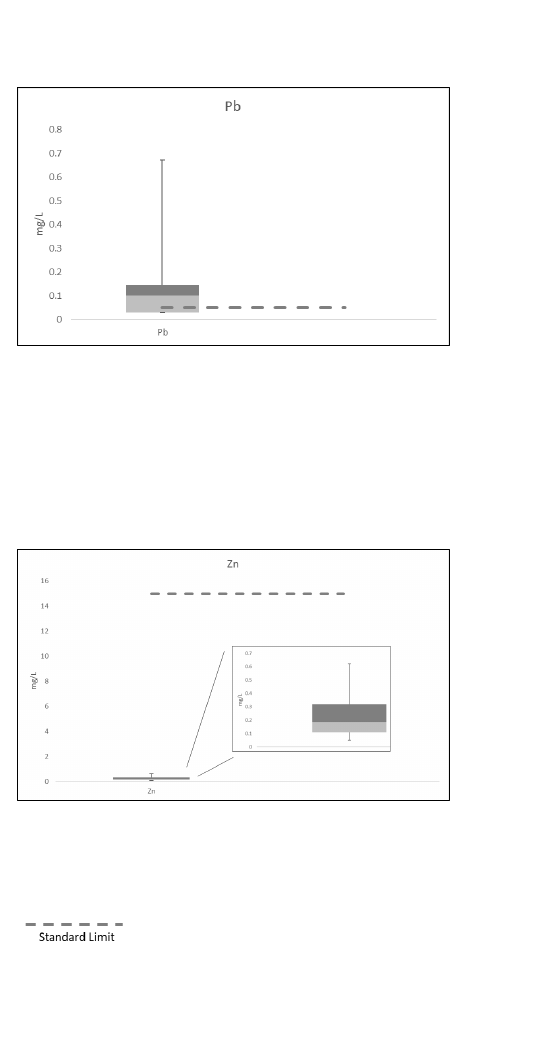
Figure 8. ( a ) Copper, ( b ) Lead, and ( c ) Zinc concentration and distribution patterns.